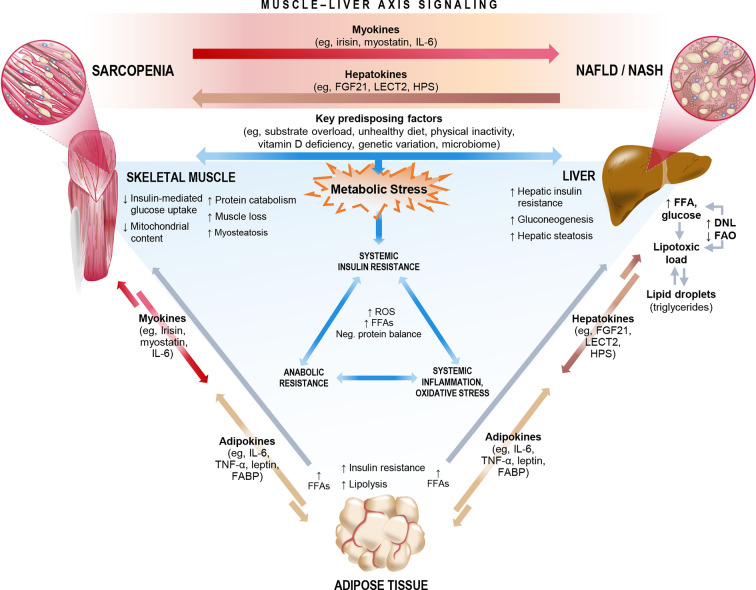
Key mechanisms and molecular signals that link sarcopenia and non-alcoholic fatty liver disease (NAFLD)/non-alcoholic steatohepatitis (NASH). The complex interorgan crosstalk between liver and muscle likely shares a number of key underlying mechanisms, many of which relate both sarcopenia and NAFLD/NASH to metabolic stress, cascading to biochemical pathways that impact systemic insulin resistance, inflammation/oxidative stress, and anabolic resistance. Among these mechanisms are a number of existing or emergent predisposing factors and the release of multidirectional molecular signals consisting of myokines, hepatokines, and adipokines. In the context of sarcopenia, skeletal muscle could exert dysregulated influence on the muscle-liver axis to potentially play a causative role in NAFLD incidence or progression. DNL, de novo lipogenesis; FABP, fatty acid-binding protein; FAO, fatty acid oxidation; FFA, free fatty acid; FGF21, fibroblast growth factor 21; HPS, hepassocin; IL-6, interleukin-6; LECT2, leukocyte cell-derived chemotaxin-2; ROS, reactive oxygen species; TNF-α, tumor necrosis factor-alpha.